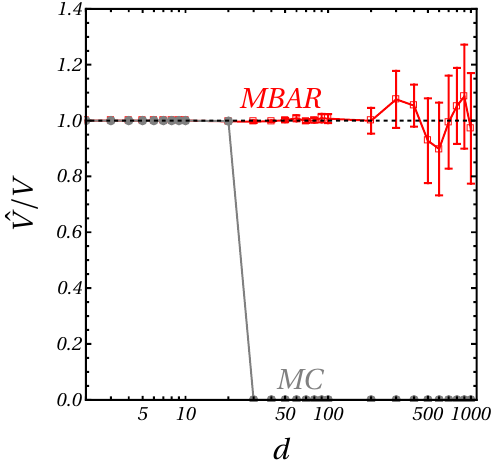
Figure 6: Volume estimates. Ratio of measured volume ˆ V to expected volume V of the unit cube against the dimensionality d , using brute-force Monte Carlo with N s = 10 8 points in the smallest ball containing the cube (gray disks) and MBAR (red squares) with K = max (64 , d/ 5) random walks linearly spaced in r , each with N s = 5 × 10 5 proposed steps. Error bars are 95% confidence intervals for the mean, using statistics across 10